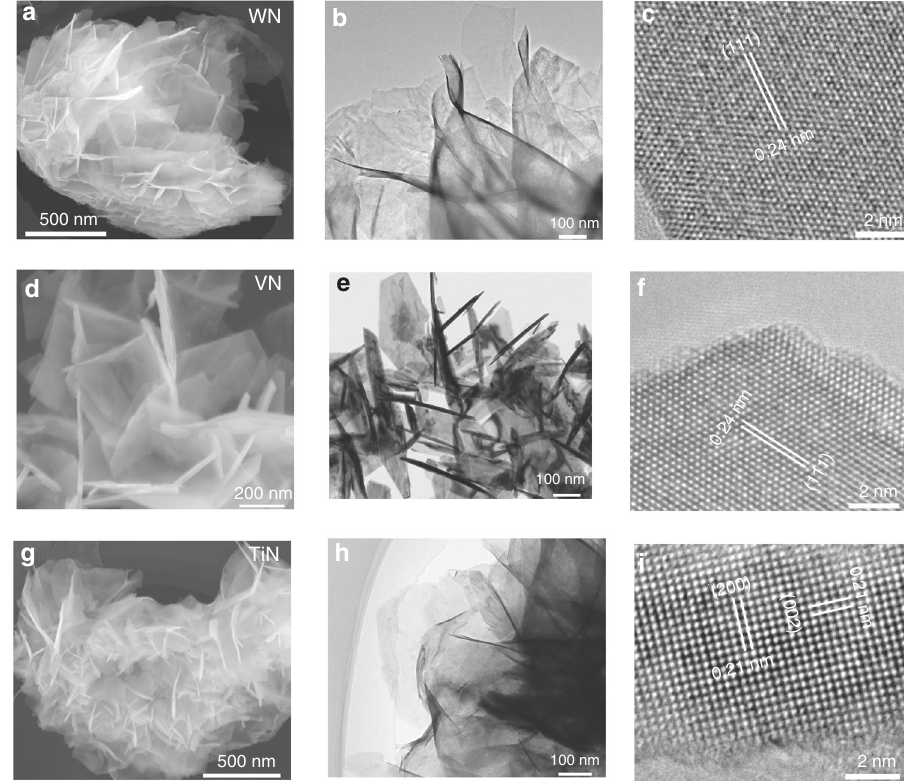
Fig. 4 Morphology and structure characterization of the nanosheets. a – c WN nanosheets. d – f VN nanosheets. g – i TiN